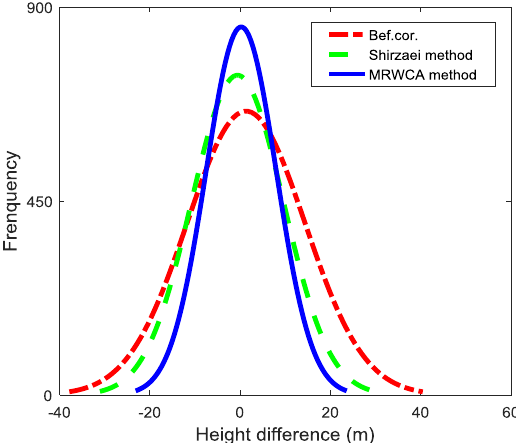
Figure 9. Histograms of the elevation differences between the ICESat data and the InSAR-derived DEMs generated without atmospheric correction, with Shirzaei’s atmospheric correction and MRWCA atmospheric correction, respectively.